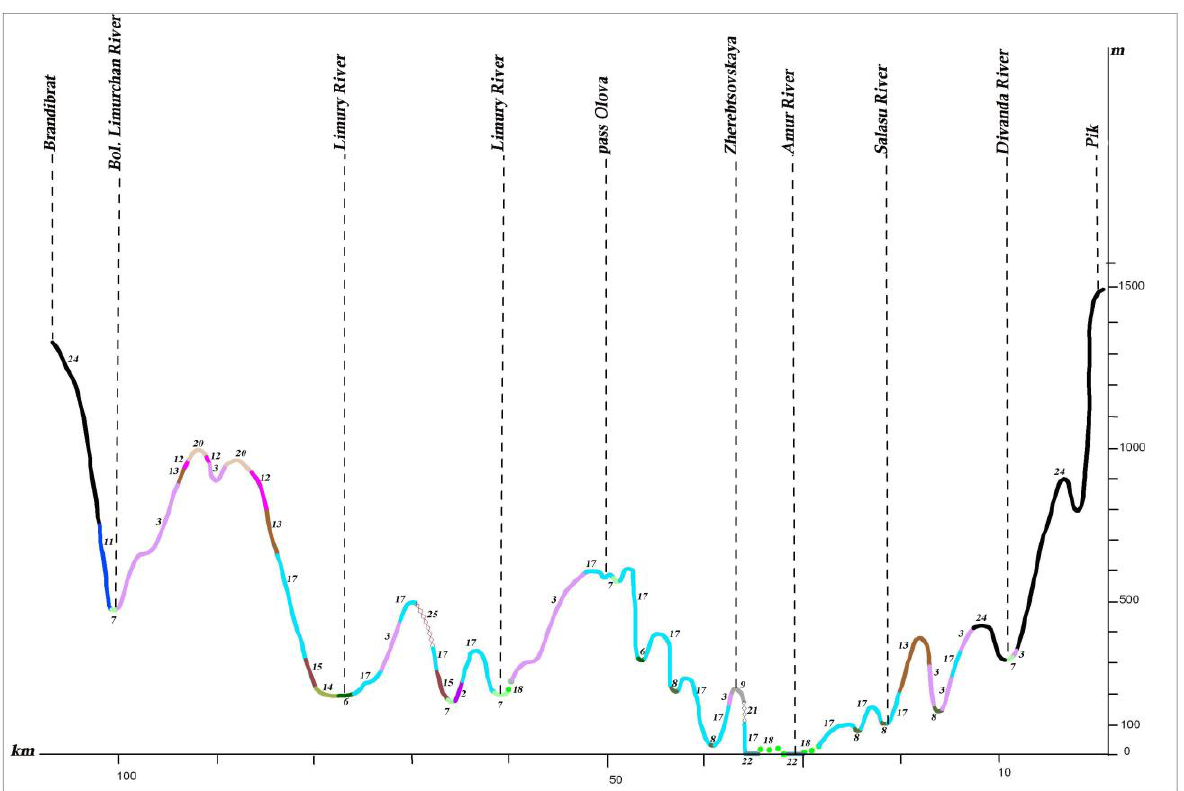
Figure 13. Profile of the plant cover from the mountain Pik to the mountain Brandibrat (II) (see the legend in the Figure 10).